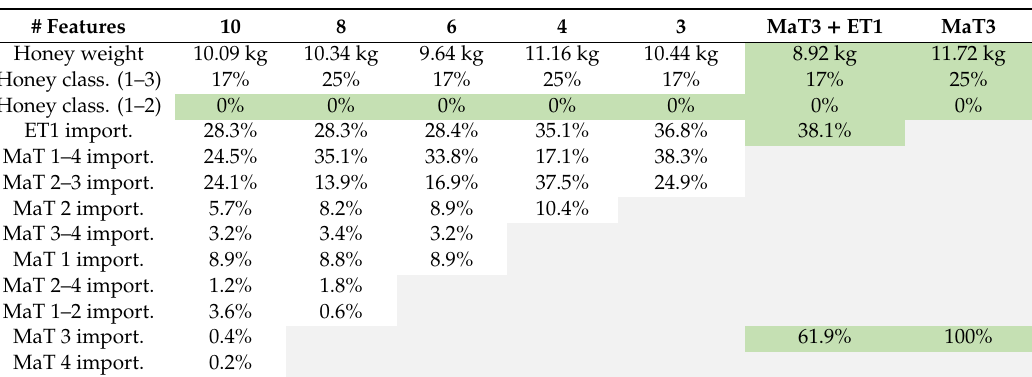
Table 7. Gradient Boosted Regression errors and the feature importance of mean temperatures 1–4 months before flowering and evapotranspiration 1 month before flowering.